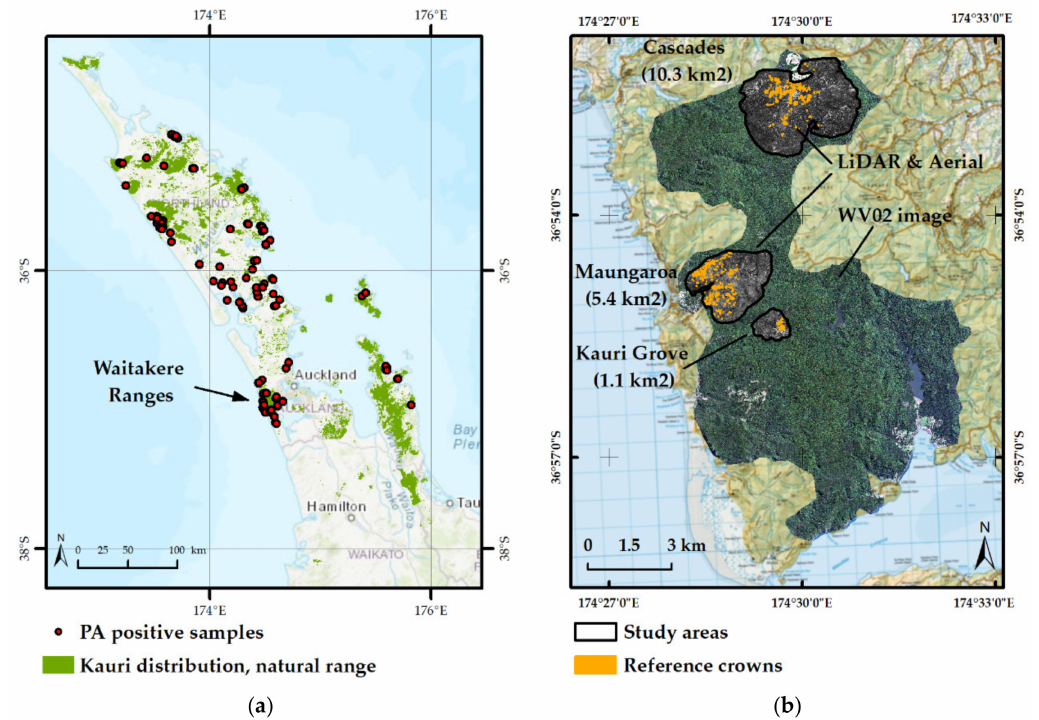
Figure2. ( a )LocationoftheWaitakereRangesontheNorthIslandofNewZealandwestofAucklandCity, with the natural range of kauri distribution and Phytophthora agathidicida (PA)-positive samples [80,81]. ( b ) Study sites and extent of the remote sensing datasets in the Waitakere Ranges, with the reference crowns marked in orange (background map: LINZ 2019